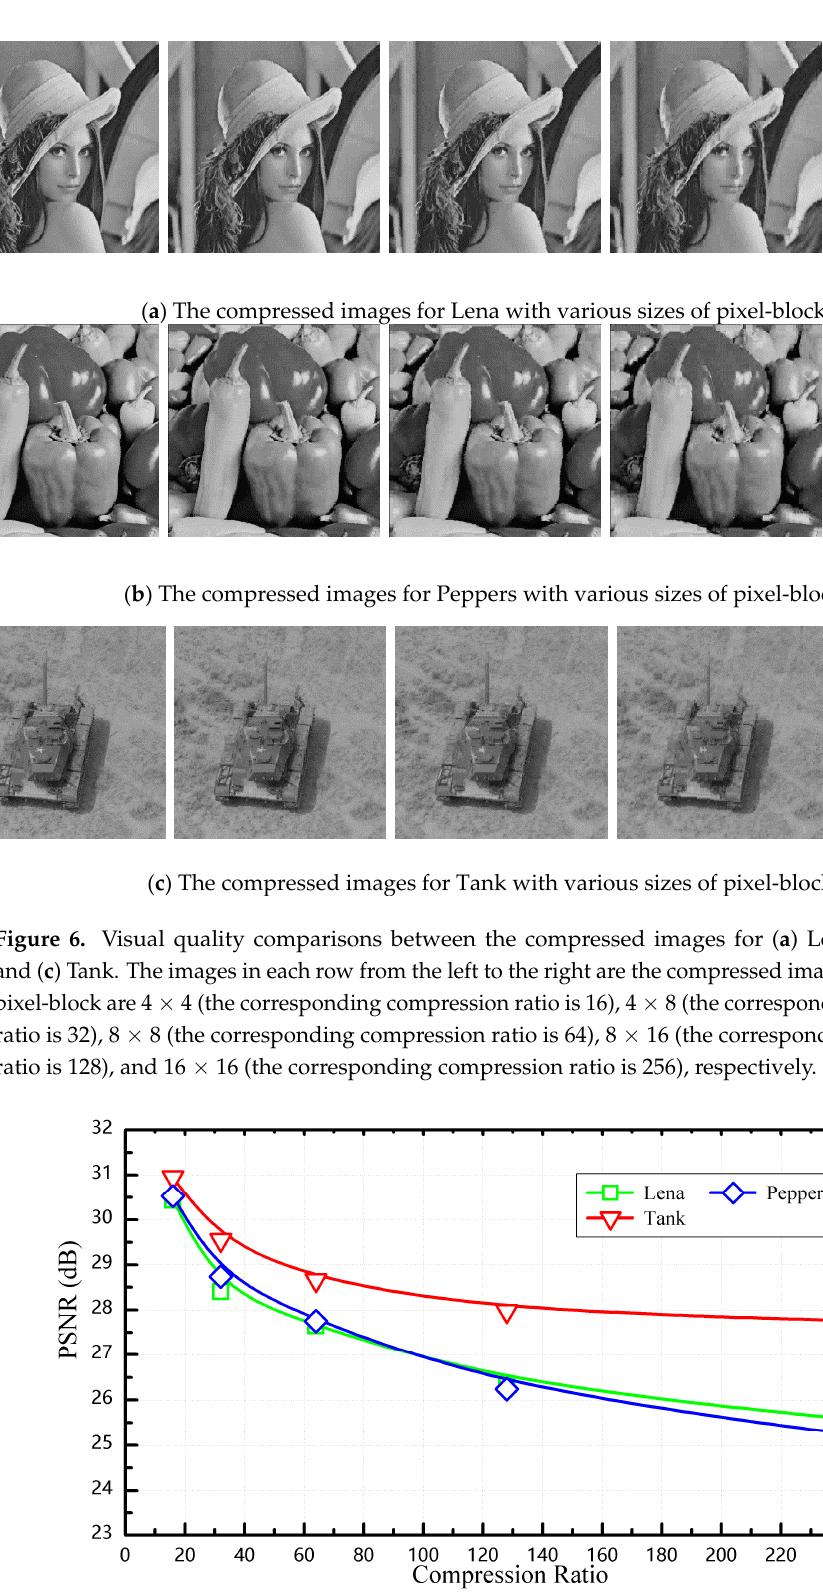
Figure 7. PSNR (peak signal-to-noise ratio) vs. compression ratio for Lena, Peppers, Tank.